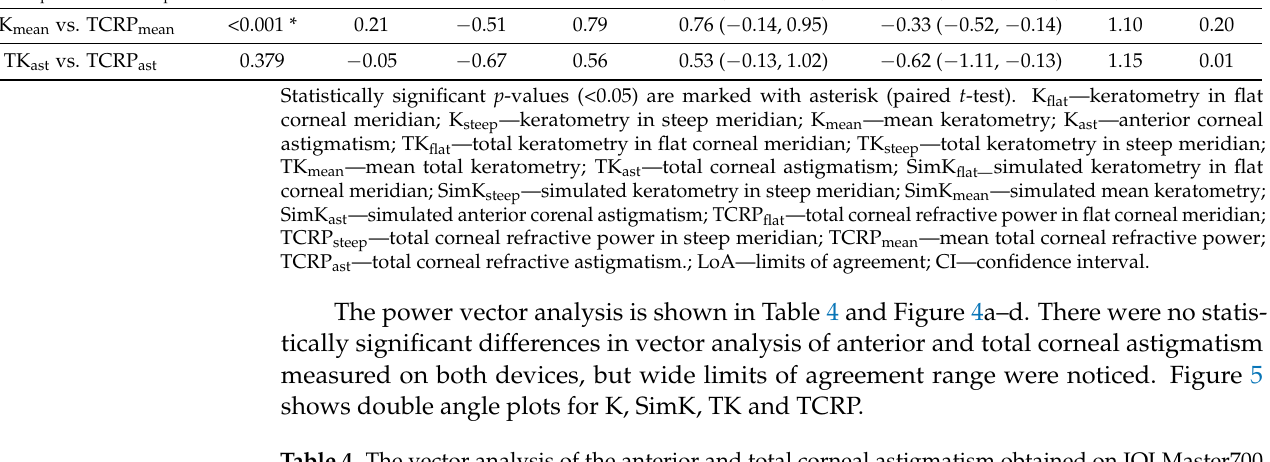
Table 4. The vector analysis of the anterior and total corneal astigmatism obtained on IOLMaster700 and Pentacam